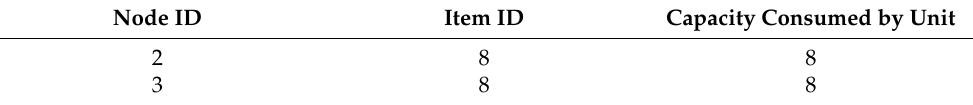
Table 3. Capacity consumed per time period by a production run in production nodes.